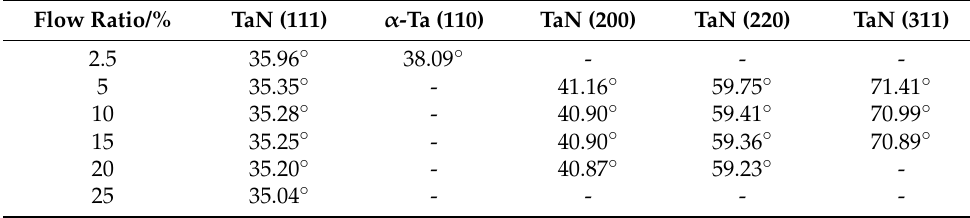
Figure 1. XRD pattern of TaN films with different nitrogen flow ratios. Table 2. XRD Peak Positions of TaN